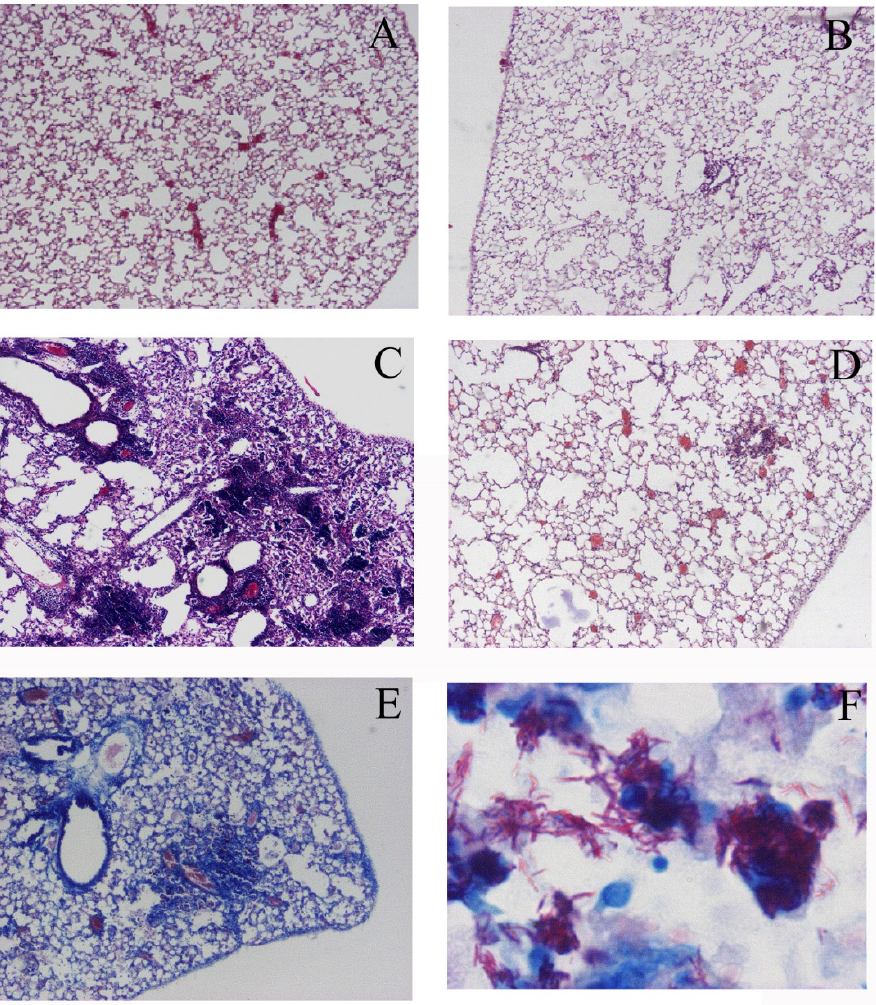
Figure 1. Histology of lungs from mice 60 days after M. avium administration. ( A ) Wild mice (C57BL/6) administered saline, ( B ) wild mice administered M. avium , ( C ) TNFR1-KO mice administered M. avium, and ( D ) TNFR2-KO mice administered M. avium. The marked inflammatory cell infiltrate in the lungs from TNFR1-KO mice was noted. (A-D) panels are H-E stained and viewed at the same magnification. Original magnification ×40. Ziehl-Neelsen staining revealed the proliferation of M. avium in lungs ( E ), ( F ) magnification ×1000. Three experiments were done and demonstrated similar results.